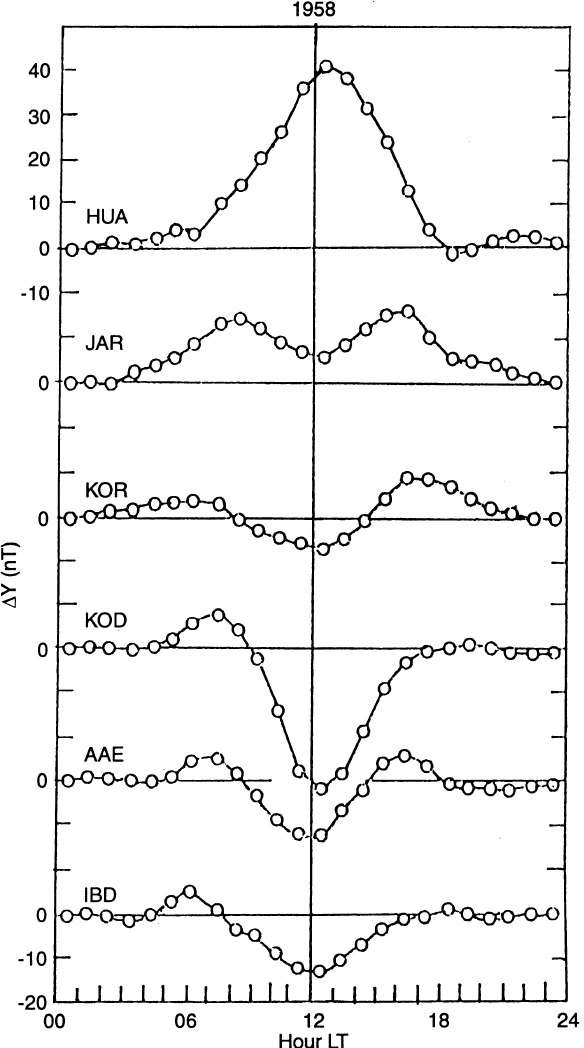
Fig. 1. Mean yearly solar daily variations of eastward components of geomagnetic field, Y , at the equatorial stations. Ibadan ( IBD ), Addis- Ababa ( AAE ), Kodaikanal ( KOD ) Koror ( KOR ), Jarvis ( JAR ) and Huancayo ( HUA )